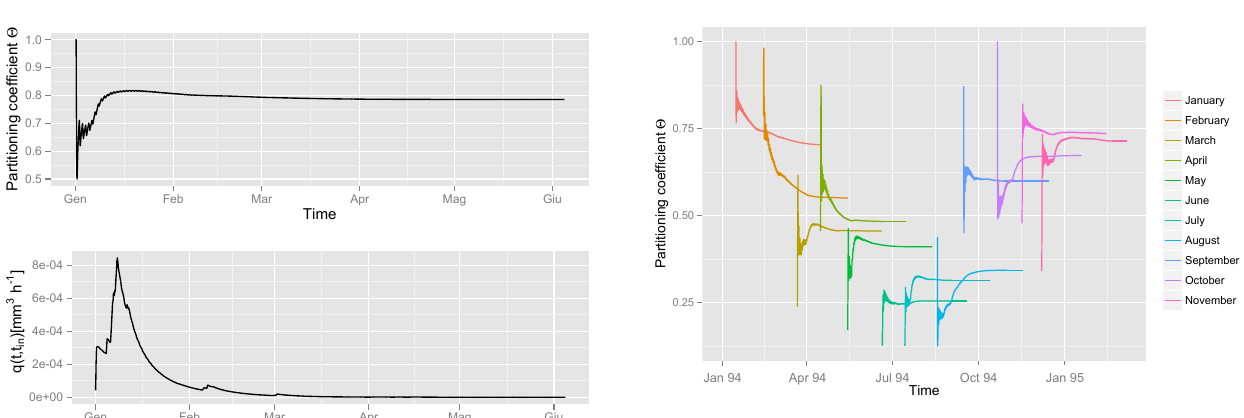
Figure 8. Evolution of the partitioning coefficient in 1 year of hourly simulation: the highest values are achieved in January, with the lowest in June. However, the figure does not represent a simple oscillation. The March coefficient is lower than April. October and November present almost the same